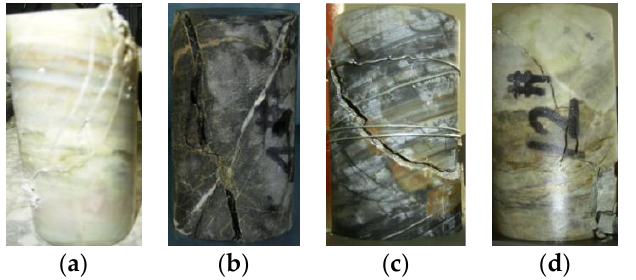
Figure 3. Shear damaged limestone samples. ( a ) 1# test specimen, ( b ) 4# test specimen, ( c ) 8# test specimen, ( d ) 12# test specimen.